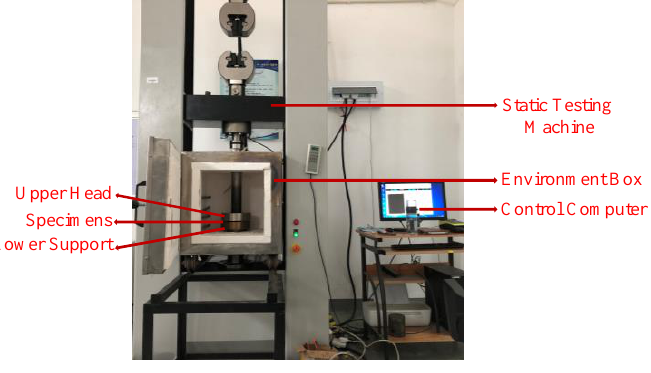
Figure 3. Experiment equipment.